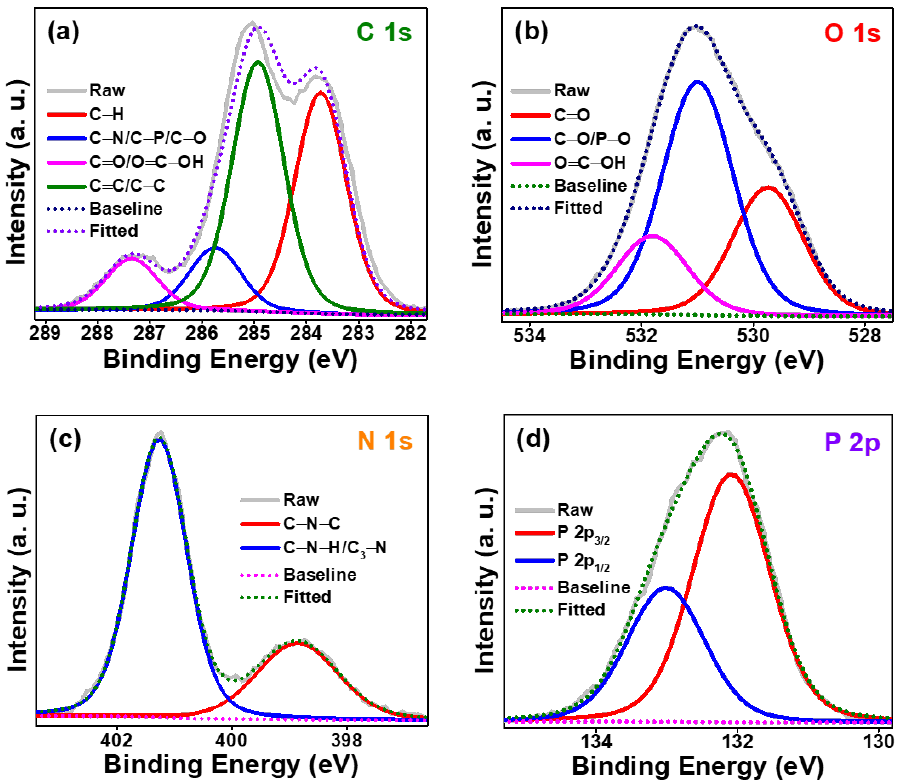
Figure 4. XPS spectra of P-CDs synthesized from PMPC. High resolution XPS of P-CDs with decon- volution of ( a ) C 1s, ( b ) O 1s, ( c ) N 1s and ( d ) P 2p levels.